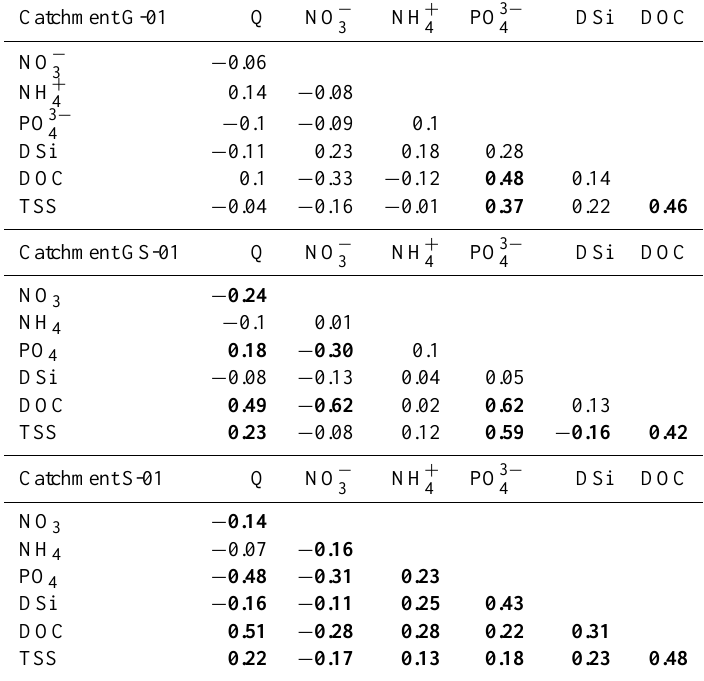
Table 2. Spearman’s rank correlations for water chemistry parameters. Significant correlations ( p <0.05, Bonferroni-corrected) are in bold. Catchment